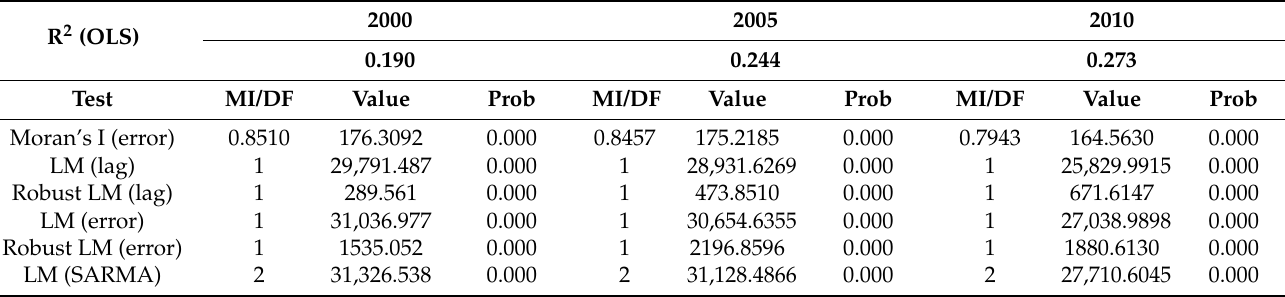
Table 8. Ordinary square regression results and spatial regression model test.